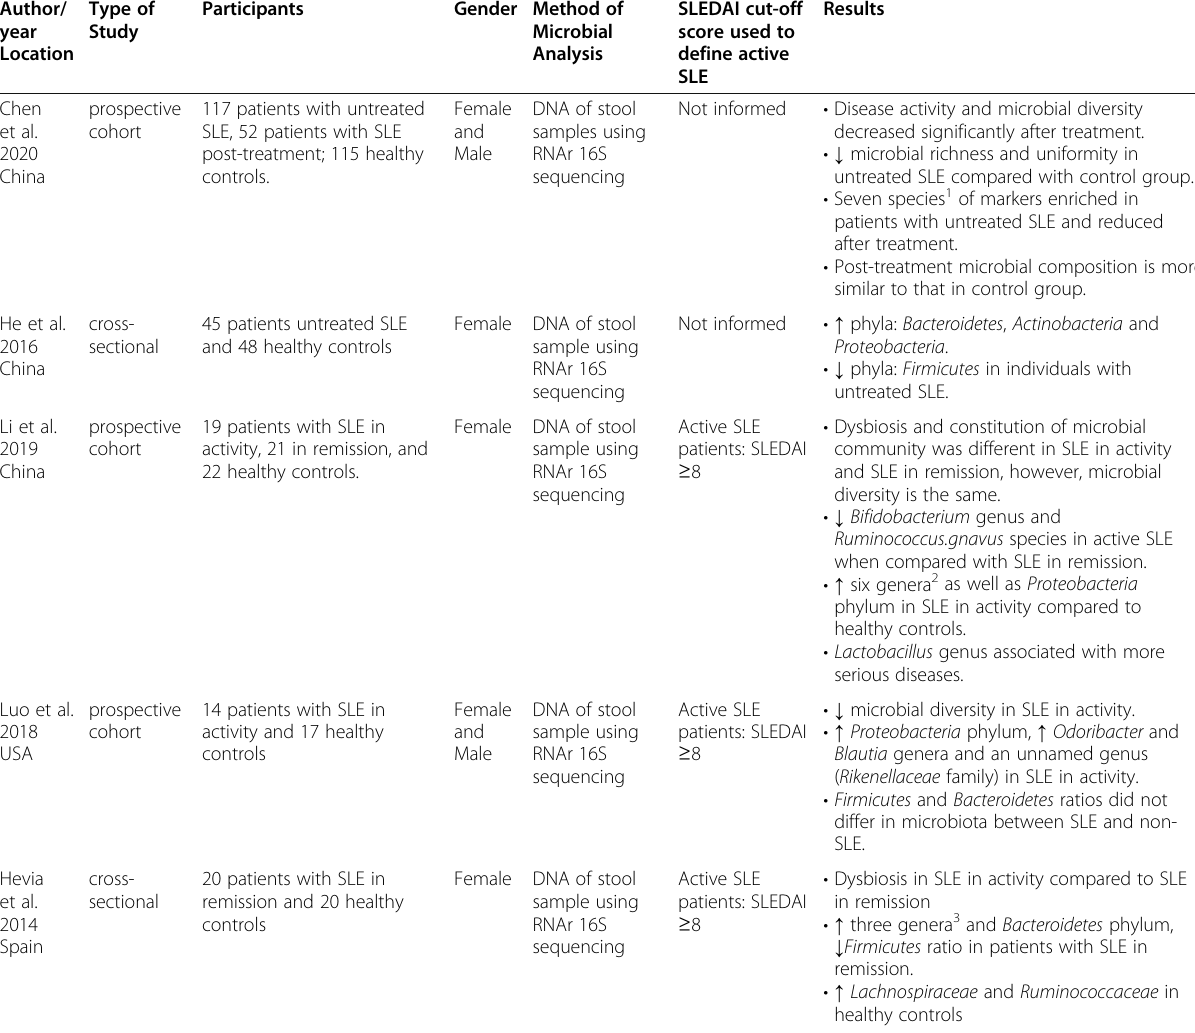
Table 2 Characteristics of the studies included in the systematic